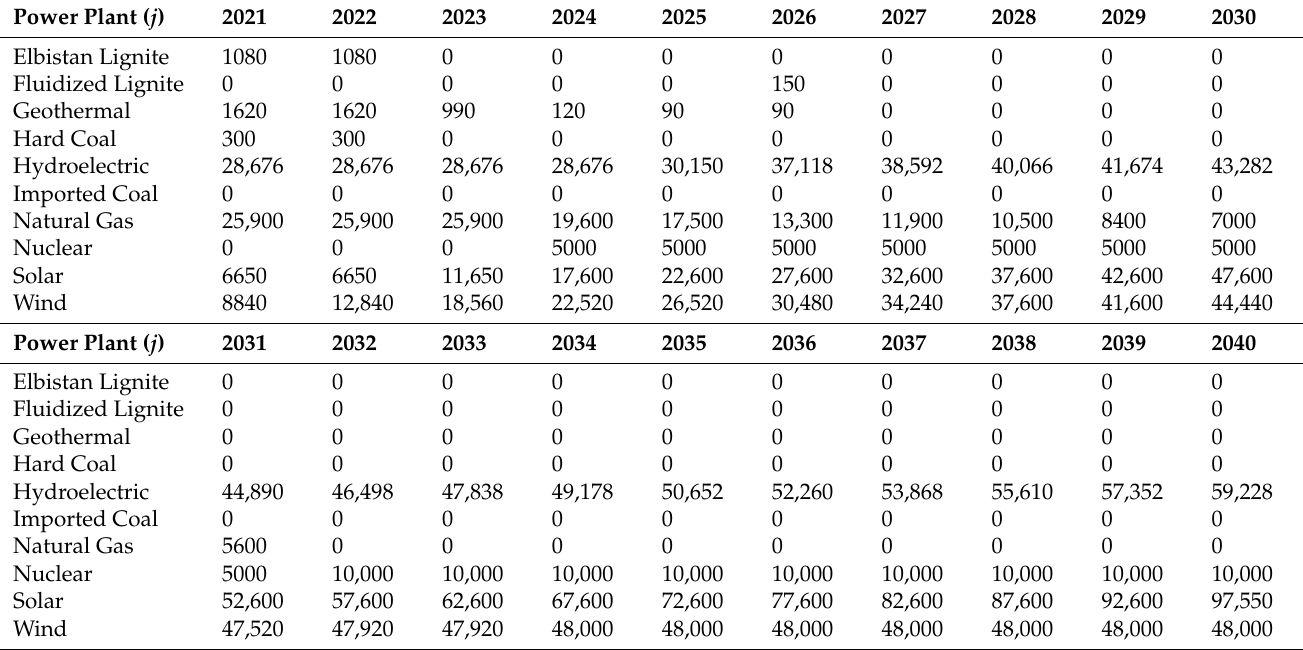
Table 5. Installed Capacities of Power Plants (MW) for the 2021–2040